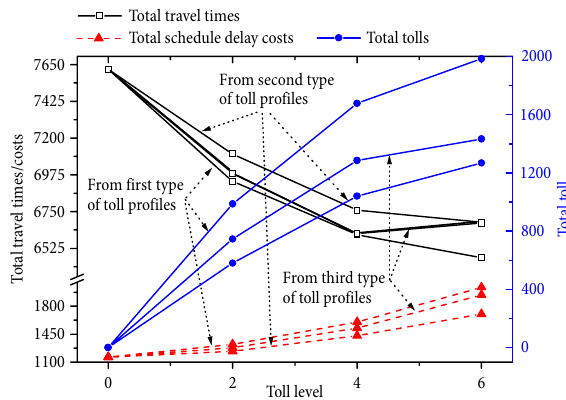
Fig. 12. Total travel times, total schedule delay costs and total